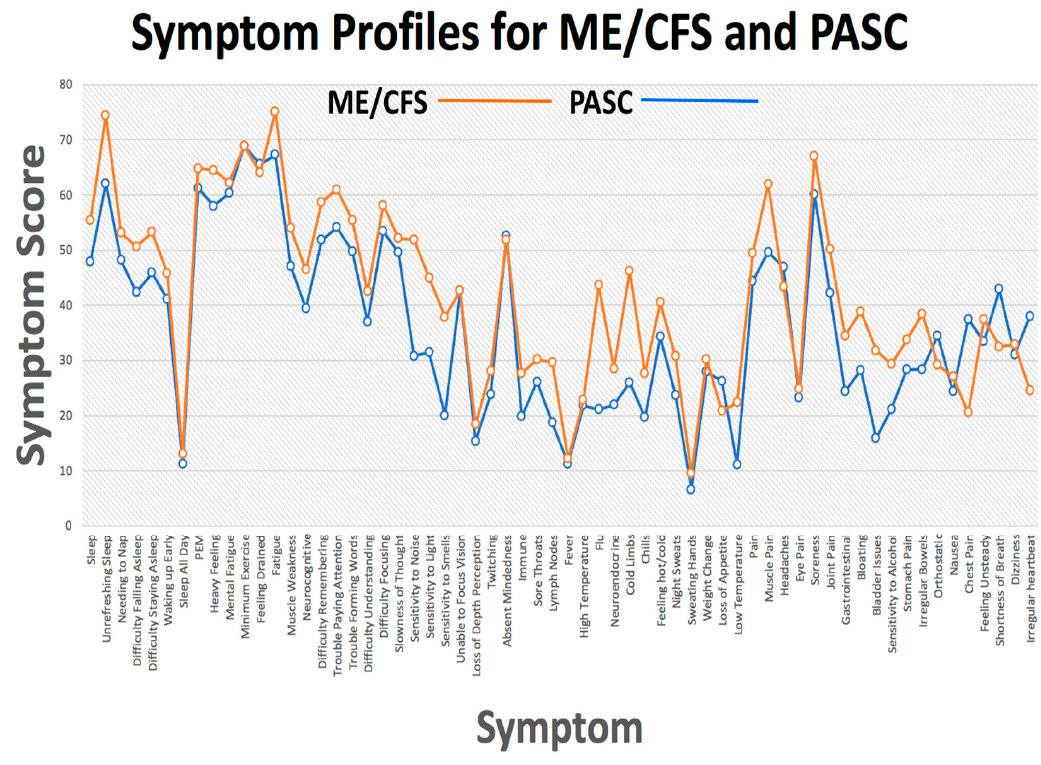
Figure 2. Symptom profiles for the PASC and ME/CFS patient groups. Data from [15]. Public do-